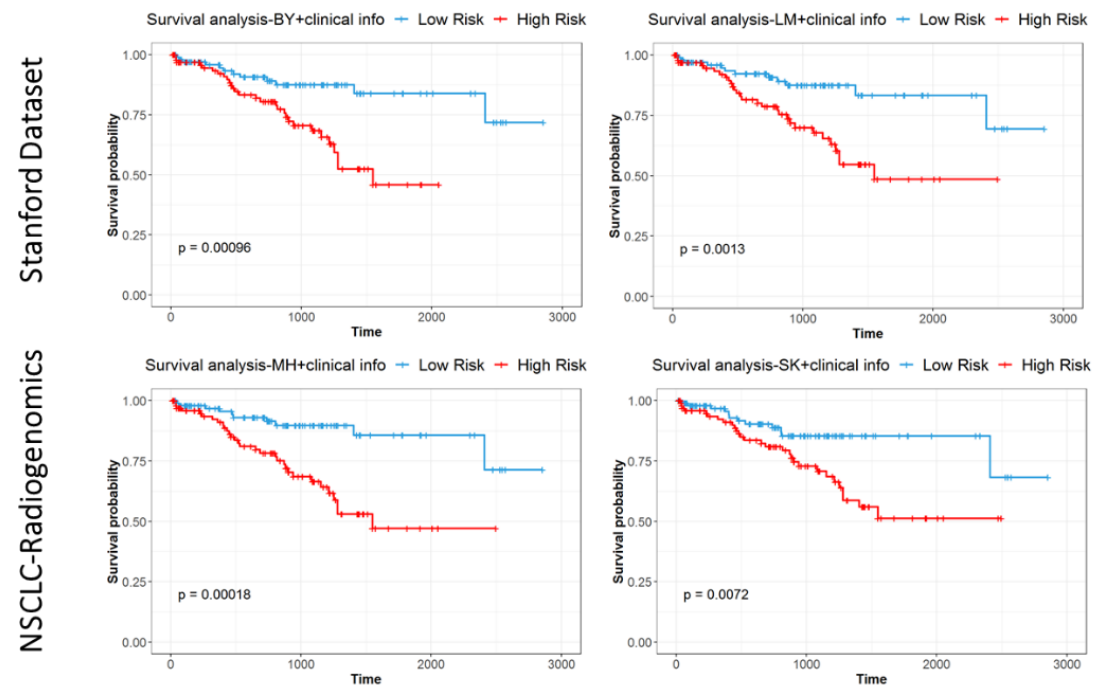
Figure 5. Kaplan-Meier curves for multivariate models of overall survival using low-rank radiomics show significant differences between high- and low-risk patients for each segmenter and NSCLC dataset using median risk score in the model.